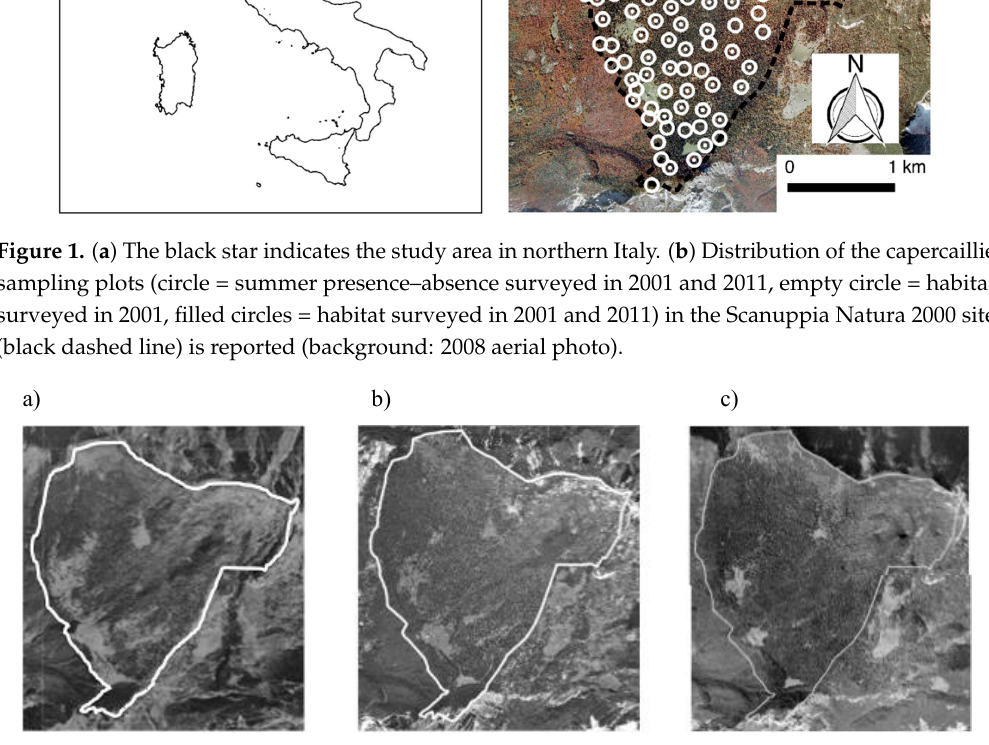
Figure 2. Historical aerial photos comparison which show the reduction of open lands from ( a ) 1954; to ( b ) 1973; and ( c ) 2006, in the Scanuppia Natura 2000 site. The altitude of the Natura 2000 site ranges between 1450 m and 2130 m a.s.l. (highest summit